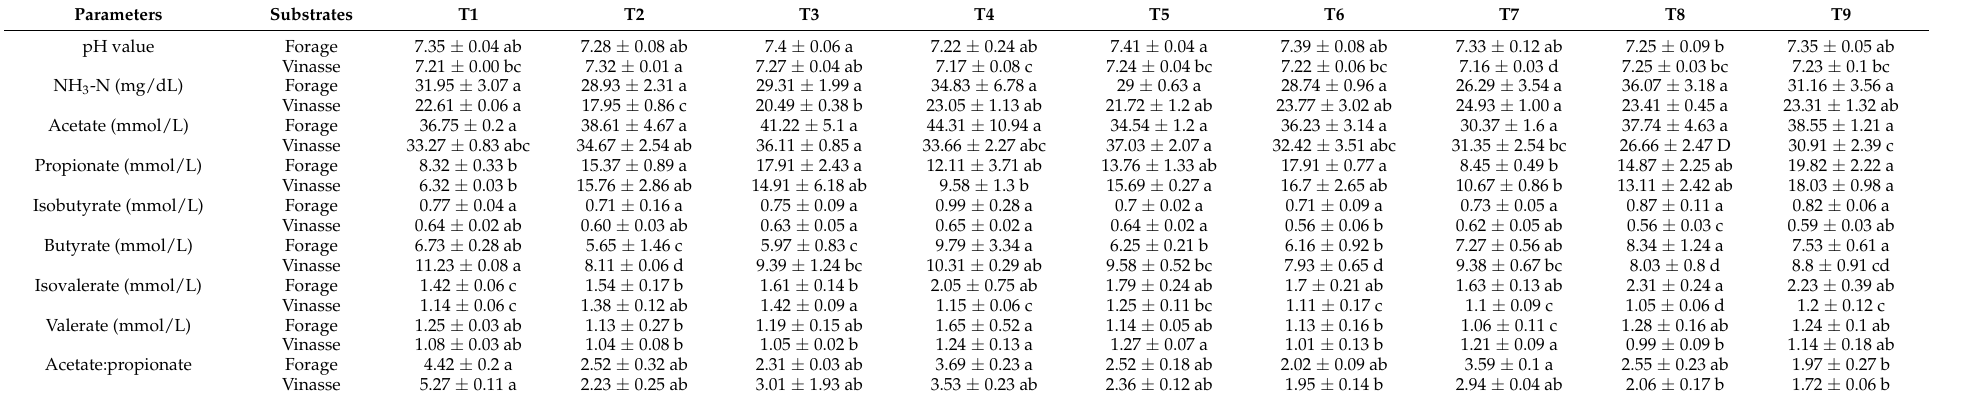
Table 2. Effect of monensin and fumarate supplementation on the in vitro rumen fermentation under different